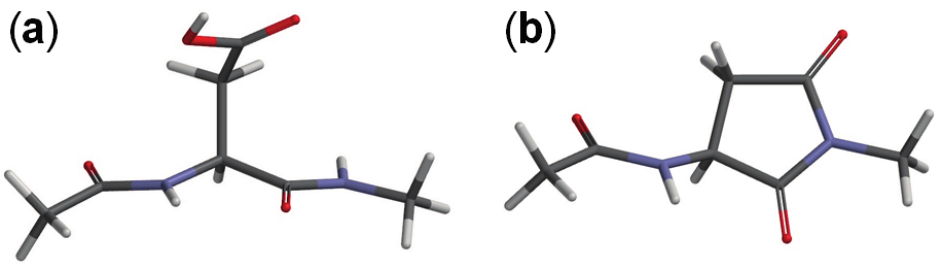
Figure 2. Energy diagram (kcal·mol − 1 ), where relative energies corrected for the zero-point energy (ZPE) and the SM8 (solvation model 8) hydration free energy are shown with respected to the reactant complex, R•AA (R, reactant molecule; AA, acetic acid). The ZPE-corrected relative energies in a vacuum are shown in parentheses for comparison. The single imaginary frequency (cm − 1 ) is also shown for TS-1 and TS-2 (TS, transition state). I, intermediate; P, product molecule; W, water.